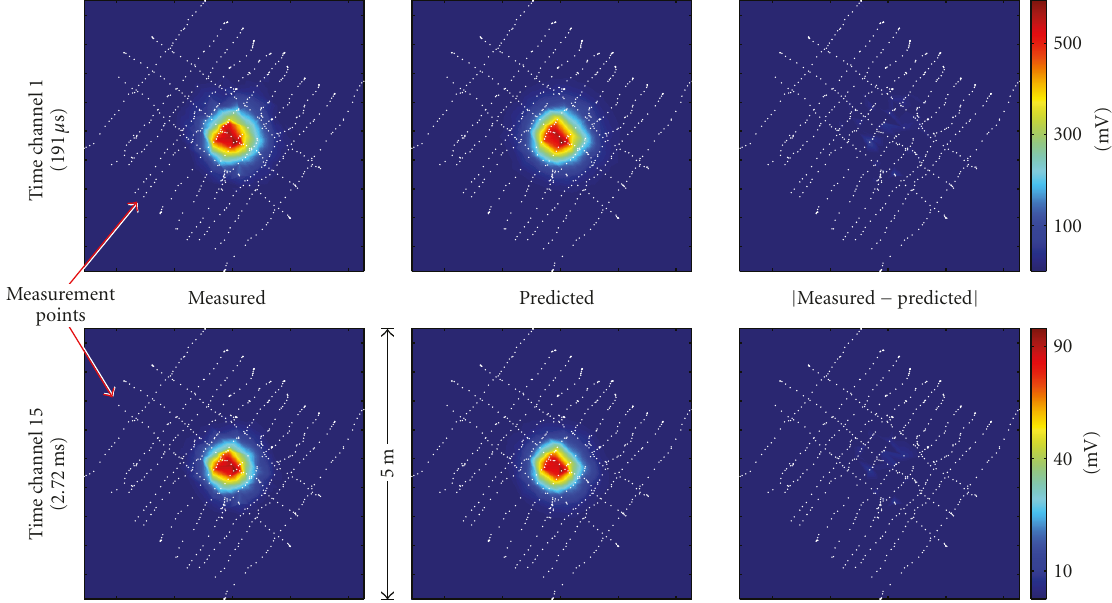
Figure 4: A typical cell from the Camp Sibert EM-63 blind test, no. 7 in this case, consists of a square plot of side 5m. The white dots show the measurement points distributed on a 668-point grid; the separation between rows is about 50cm and that between consecutive points is some 5cm. The contour plots show the measured (left column) and HAP/NSMS-predicted (middle column) near-field distributions for this cell, as well as the mismatch between the two (right column), for two time gates. The first time channel (top row) is taken 191 μ s after shutdown; the 15th (bottom) is centered at